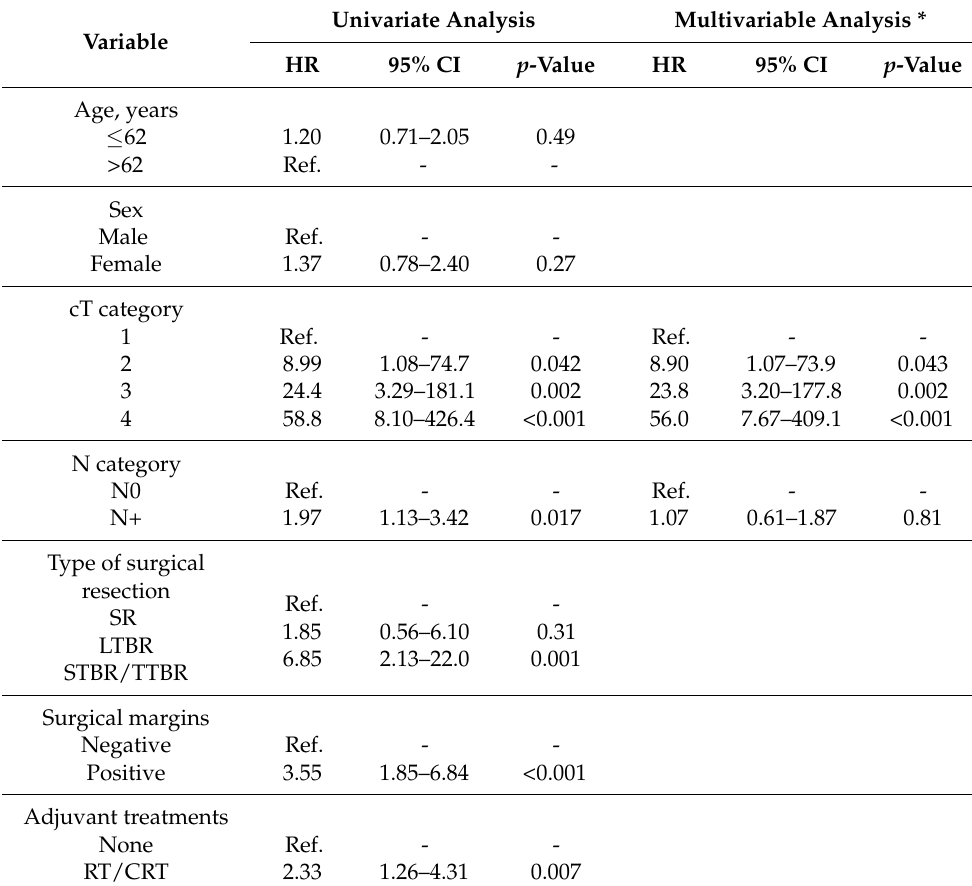
Table 4. Univariate and multivariable analysis of pooled data for